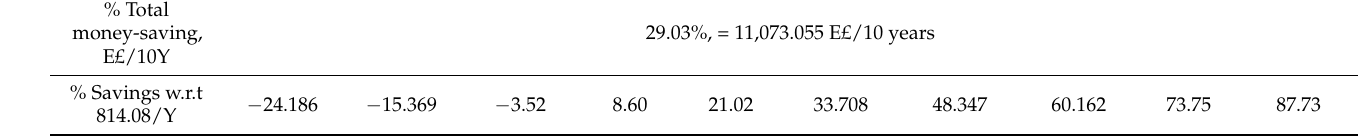
Table 7 values are derived from Equation (19) after multiplying Equation (18) by 0.94 (error of 0.06):